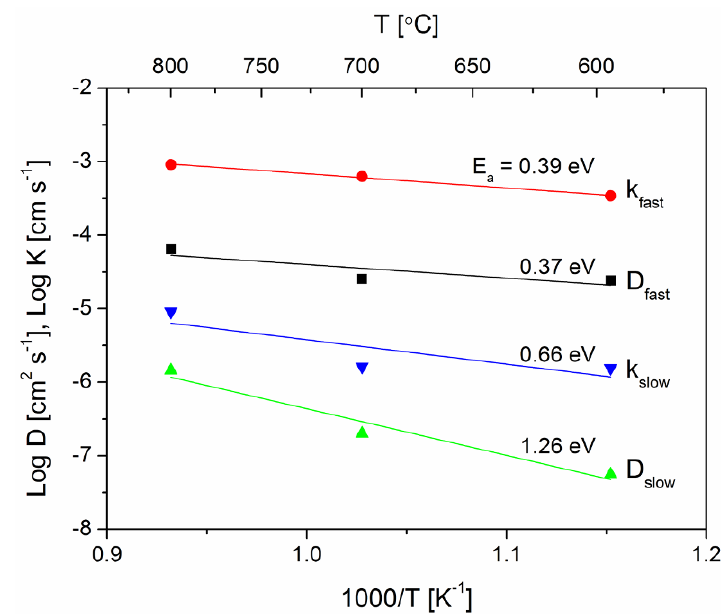
Figure 8. Surface exchange coefficient (k) and proton diffusion coefficient (D) in SrZr